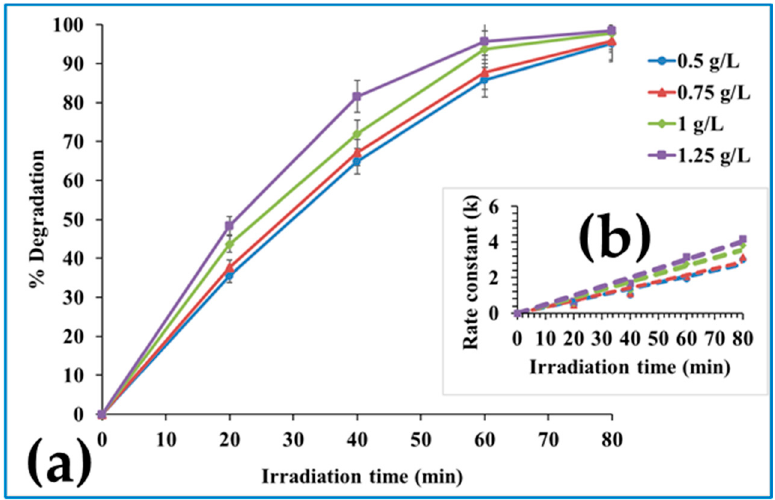
Figure 13. ( a ) Effect of catalyst dosage on the photocatalytic degradation performance of Mo/HRTiO 2 over 50 mg/L initial IBU concentration under natural (unmodified) pH ~ 4 and 365 nm irradiation, and ( b ) their corresponding photocatalytic degradation rate constant (k).